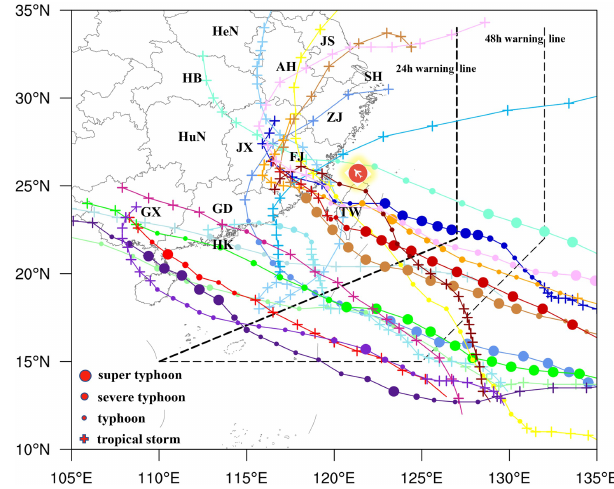
Figure 1. The tracks (lines) and categories (symbols) of 17 ty- phoons that made landfall in Southern China over the western Pa- cific between 2014 and 2018. The thin and thick black dashed lines represent the 48 and 24h typhoon warning lines respectively. The locations and boundaries of the provinces of interest are in- dicated by the following abbreviations: Anhui (AH), Fujian (FJ), Guangdong (GD), Guangxi (GX), Henan (HeN), Hubei (HB), Hu- nan (HuN), Jiangsu (JS), Jiangxi (JX) and Zhejiang (ZJ). Shang- hai (SH) district is also shown. The location where vertical ozone profiles are available at Taoyuan International Airport (25.076 ◦ N, 121.224 ◦ E) in Taiwan (TW) is marked using a red plane